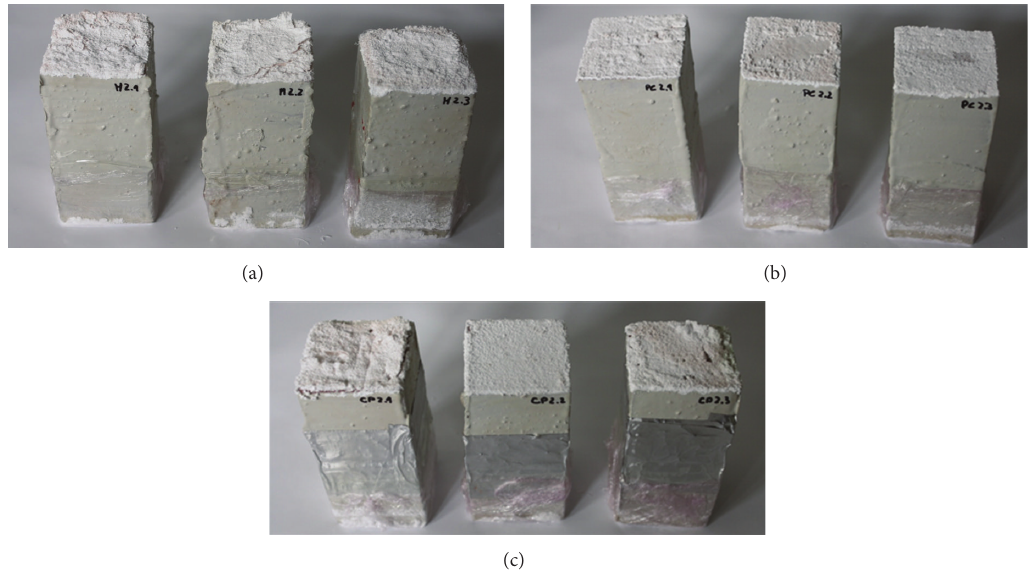
Figure 2: Illustration of some samples before the beginning of the 2 ∘ cycle tests: (a) monolithic specimens, (b) hydraulic continuity interface, and (c) perfect contact